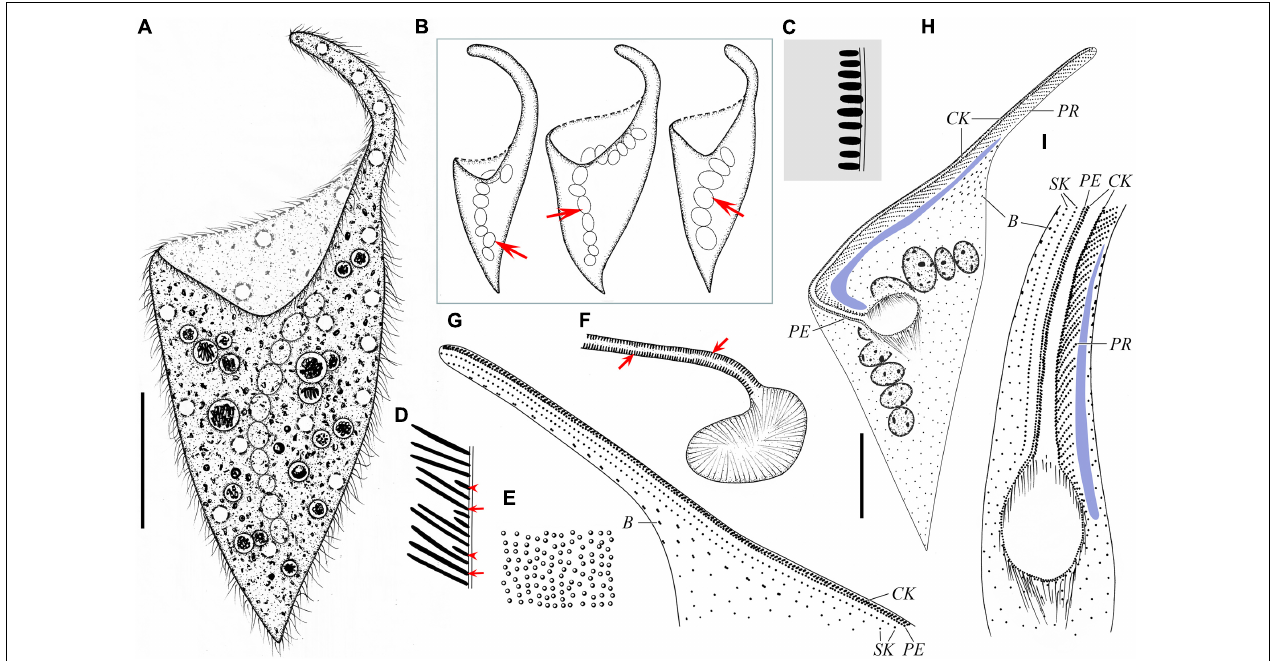
FIGURE 4 | Schematic drawings of Paradileptus conicus from life (A–F) and after protargol staining (G–I) . (A) Ventral view of a typical individual. (B) Three individuals to show different body shapes and the moniliform macronucleus (arrows). (C) Schematic drawing of a cross-section of the cortex showing the oblong cortical granules. (D) Schematic drawing of a tangential optical section of the proboscis; arrows mark the rod-shaped type I extrusomes; arrowheads indicate the oblong type II extrusomes. (E) Cortical granules underneath the pellicle. (F) Detail of oral apparatus, showing the oral opening, the basket supported by fibers, and the oblong type II extrusomes (arrows) attached to the proboscis oral bulge. (G,H) Ventral (H) and dorsal (G) views of the same individual showing the ciliary pattern. (I) Oral region showing the oral opening, glabrous area (blue block), recognizable somatic kineties, perioral kinety, circumoral kinety, dorsal brush, and obliquely oriented preoral kineties. B, dorsal brush; CK, circumoral kinety; PE, perioral kinety; PR, preoral kineties; SK, somatic kineties. Scale bars = 40 µ m (A,H)